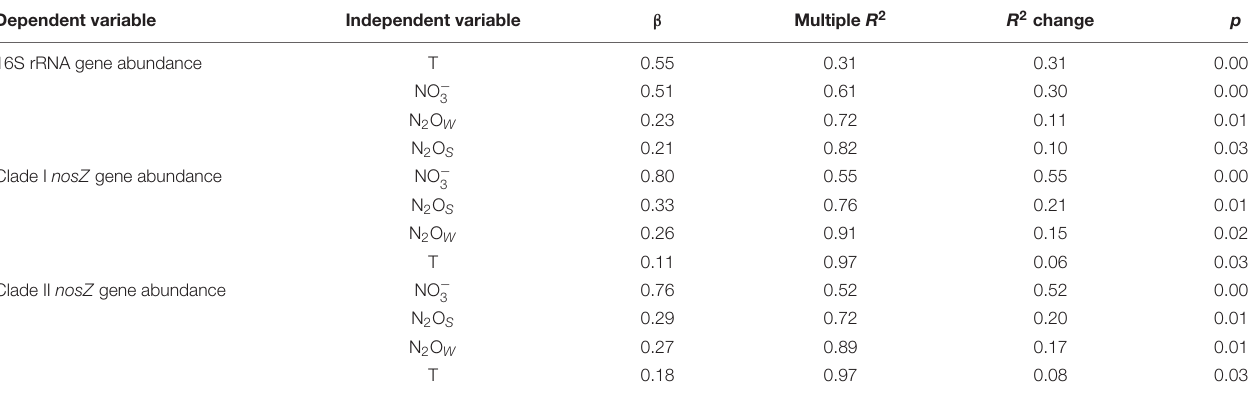
TABLE 4 | Multiple stepwise regression analysis among biotic-dependent variables (targeted genes abundance) and the independent variables that best explained NMDS ordination. Dependent